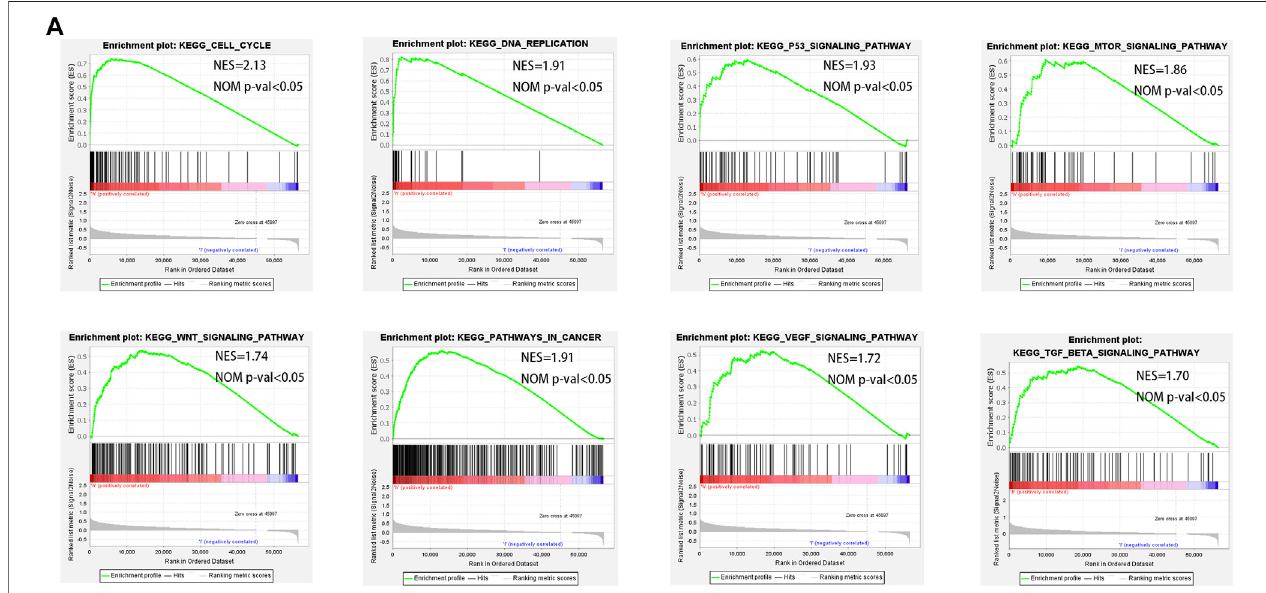
FIGURE8 | GSEA enrichment between low- and high-risk groups. (A) GSEA analysisshowing thatgeneswere enriched for thecharacteristics of malignant tumor in the high-risk